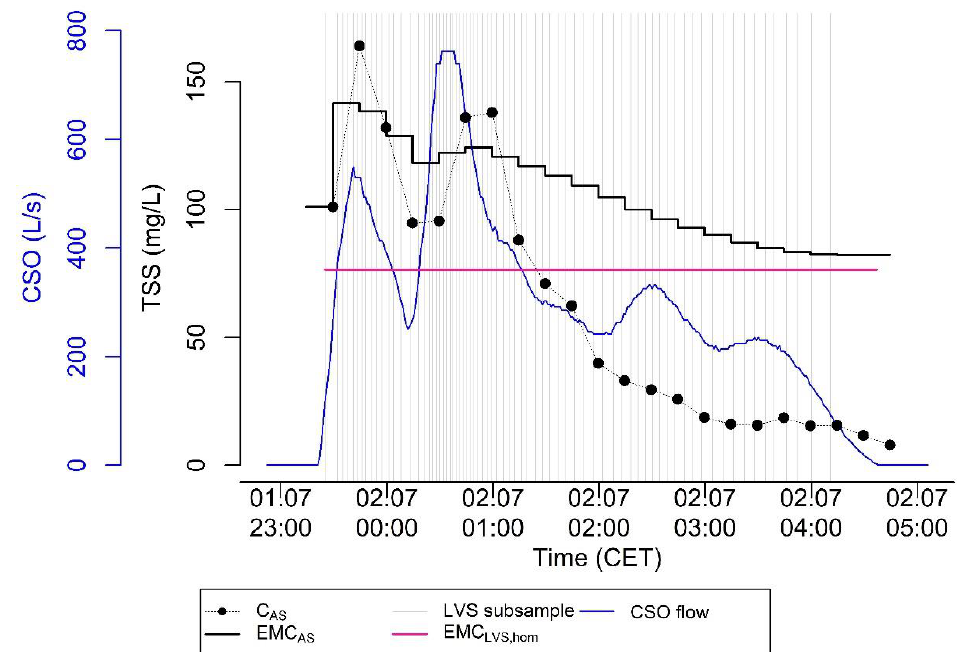
Figure 5. Evolution of the TSS event mean concentrations (EMC AS ) derived from the autosamplers pollutograph (C AS ) during a combined sewer overflow (CSO) event compared to the EMC derived from the large-volume samplers (EMC LVS,hom ).